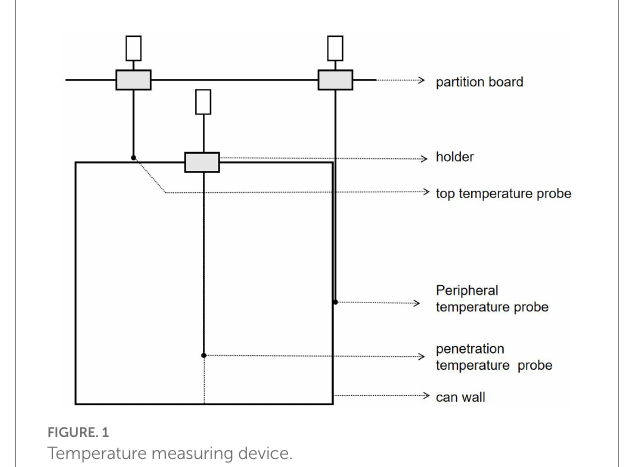
FIGURE. 1 Temperature measuring device.